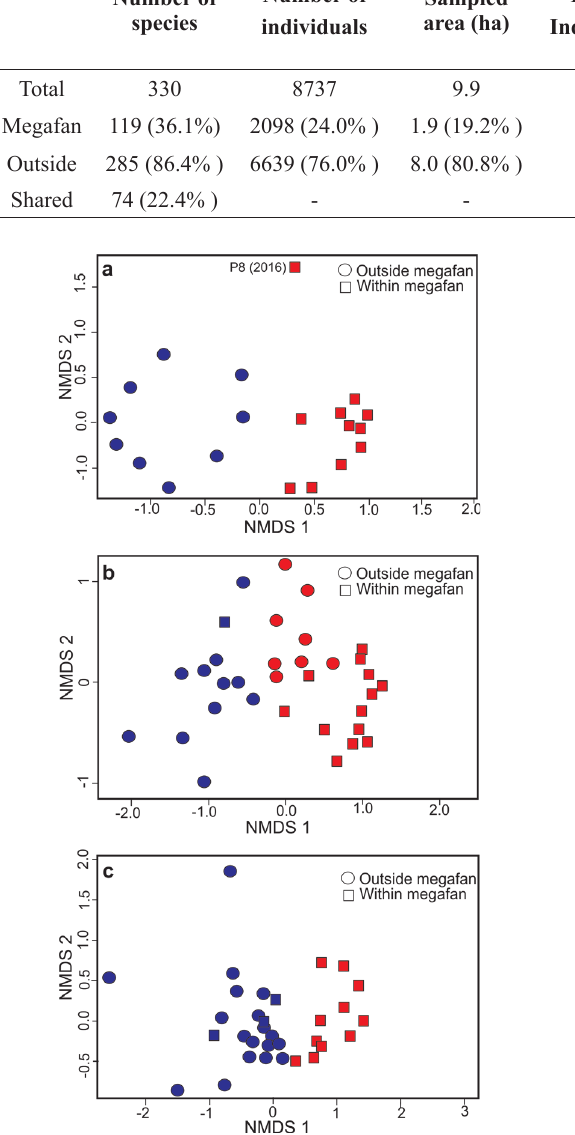
Figure 4 - Patterns of floristic similarity between plots in the area of the Viruá megafan, as visualized with NMDS ordination optimized for two dimensions. the plots are colored according to a non hierarchical k-means cluster classification using 2 clusters (blue=cluster 1; red=cluster 2). Symbols indicate whether each plot is in megafan sediments or older basement rocks. the plots close together share a larger proportion of species, calculated by Bray-Curtis distances, than the plots that are more separated. a ) trees. b ) Pteridophytes. c )